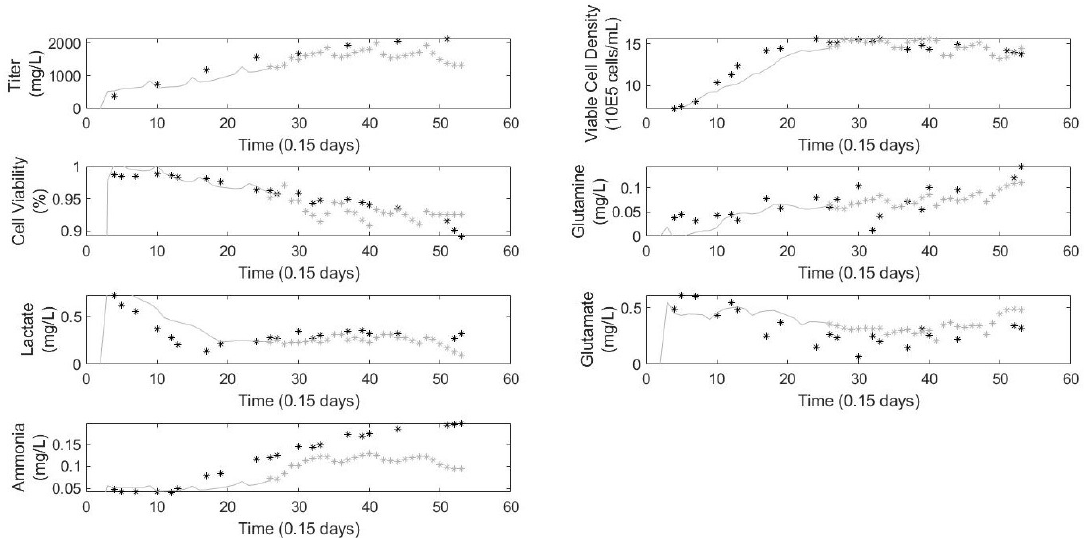
Figure 5. The process data (black) is compared with the dynamic model predictions using the state observer (grey solid) until the states converge and then the dynamic model predicts the remainder of the validation batch (grey